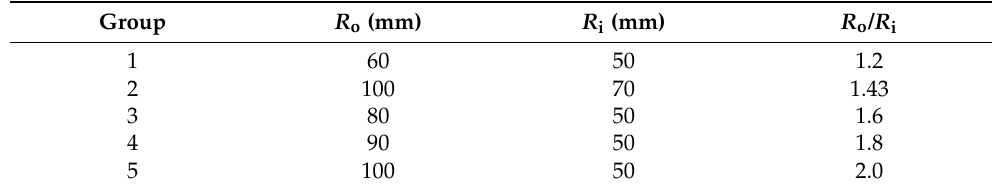
Table 6. Outer and inner radius in each group of calculation.